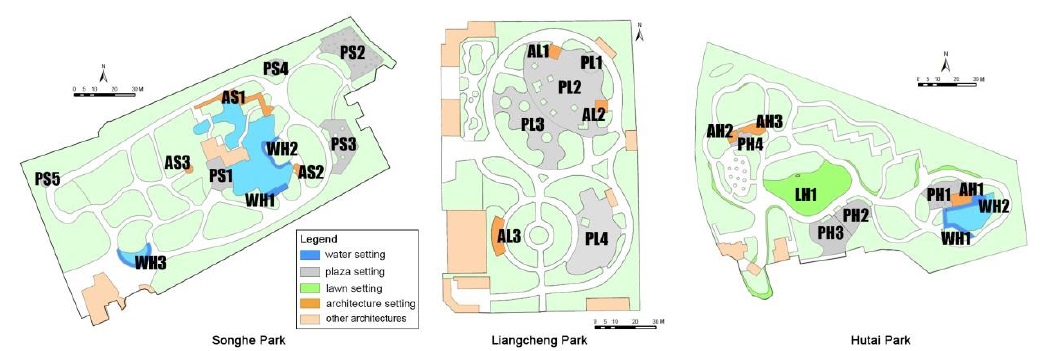
Figure 3. Codes of the behavior settings in parks. The first capital letter of the code is the abbreviation for the setting, and the second capital letter is the abbreviation for the park. Table 2. List of behavior settings in the three neighborhood parks. Setting Type